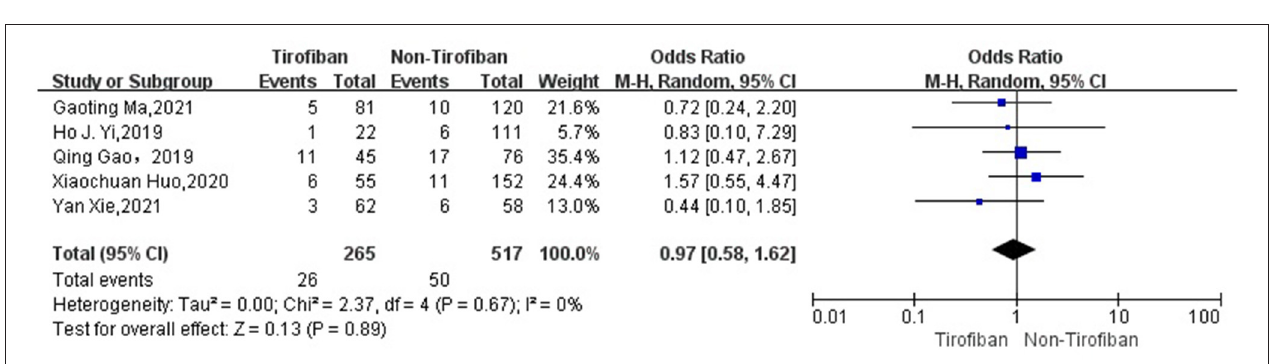
FIGURE 3 | Forest plot and meta-analysis of postoperative recanalization rate.